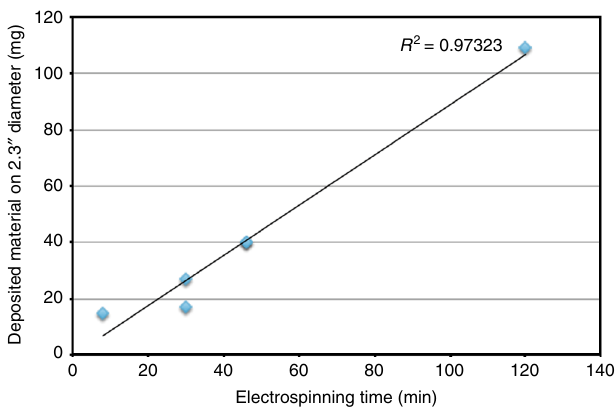
Fig. 7 The production rate plotted over time. The weight of deposited material on a 2.3 ” diameter collector shows a linear increase over